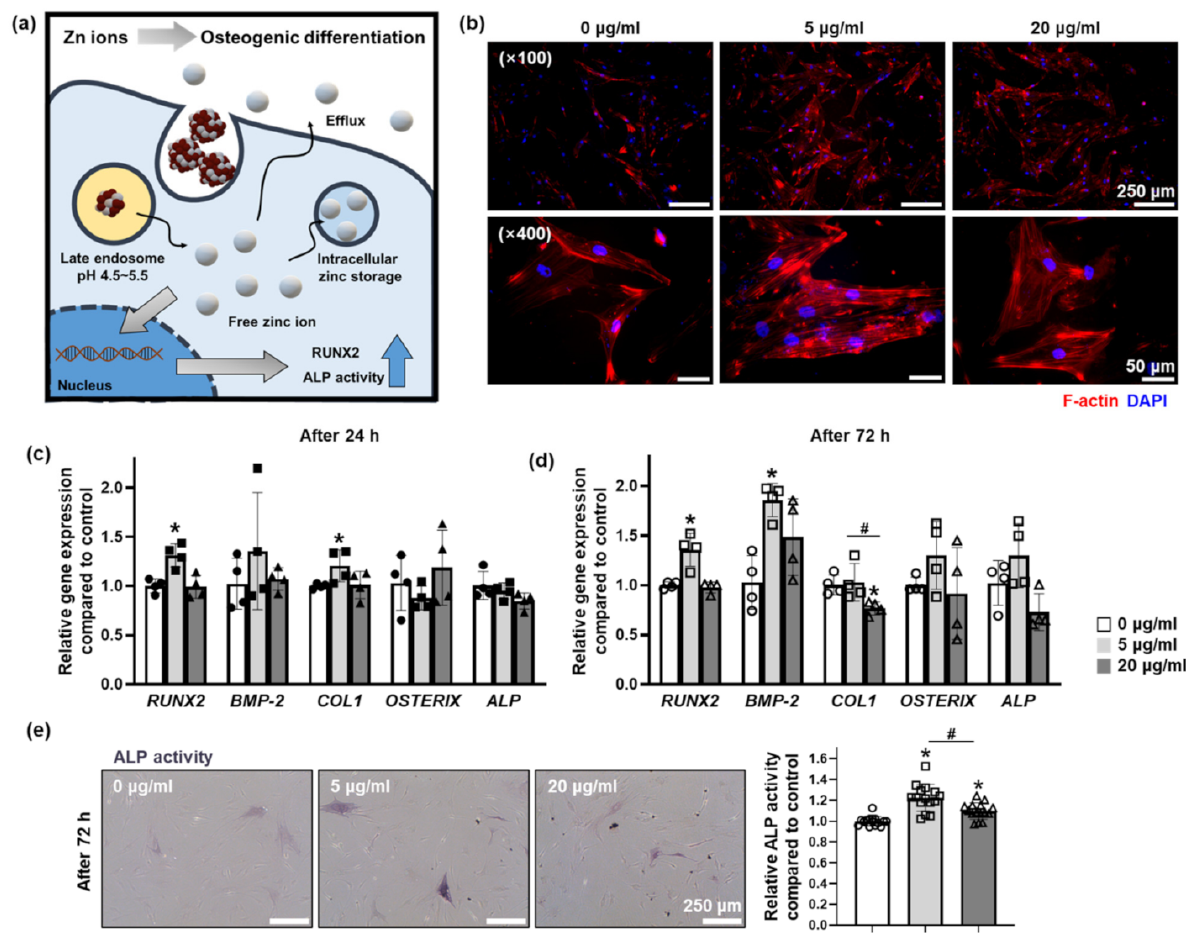
Figure 4. Effect of Zn ions released from ZIOs on osteogenic differentiation of hMSCs. ( a ) Schematic illustration describing the effect of Zn ions on hMSCs to osteogenic differentiation. ( b ) Fluorescence images of F-actin (red) in the hMSCs after the ZIOs treatment (72 h). The nuclei were stained with DAPI (blue). Scale bars indicate 250 µ m ( × 100) and 50 µ m ( × 400). Expression of osteogenic differentiation related genes, Runx2 , bone morphogenetic protein 2 (BMP-2) , collagen 1 (COL1) , OSTERIX , and alkaline phosphatase (ALP) after treating the ZIOs for ( c ) 24 h or ( d ) 72 h (* p < 0.05, compared to the control group (0 µ g/mL group)). ( e ) Representative images of ALP staining (left, purple) in the hMSCs at 72 h. Scale bars indicate 250 µ m. The ratio of the relative ALP activity in hMSCs after the ZIOs treatment (right, 72 h) (* p < 0.05, compared to the control group, # p < 0.05, compared to each